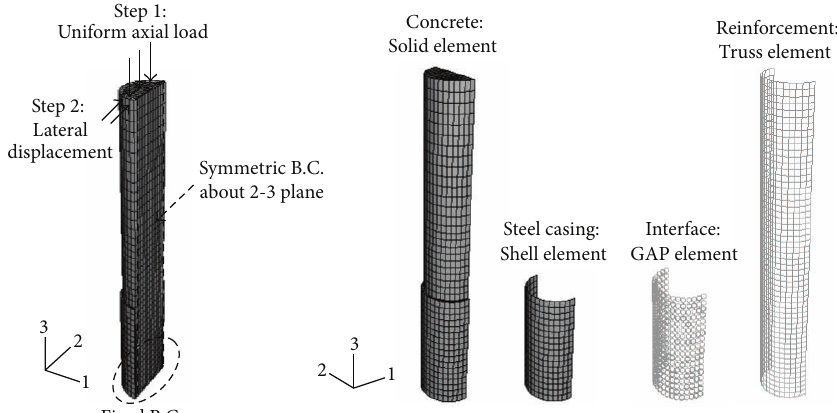
Figure 3: Boundary condition, loading, and element used in the finite element